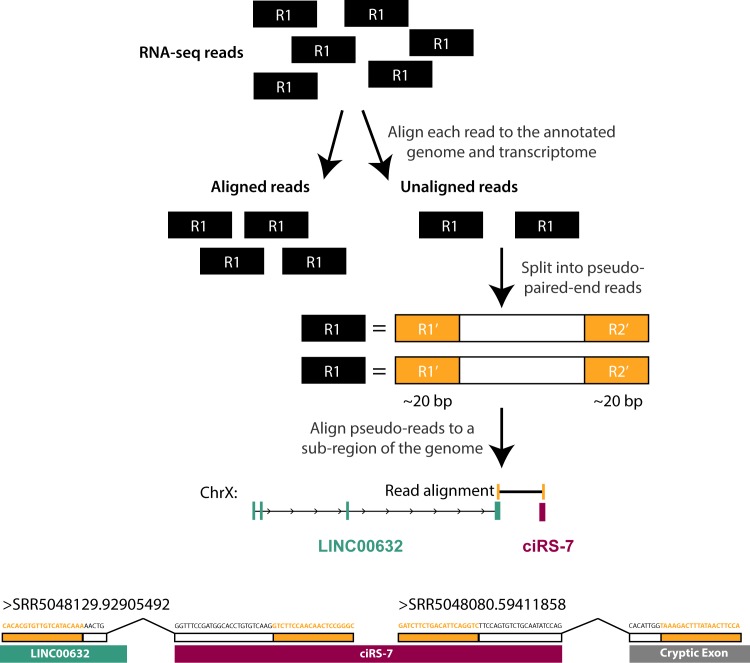
(Upper) Schematic outlining RNA-seq split read mapping approach.(Lower) Unannotated linear splicing is predicted up- and downstream of the ciRS-7 exon. Reads supporting these junctions are shown above the locus. Note, features are not drawn to scale.